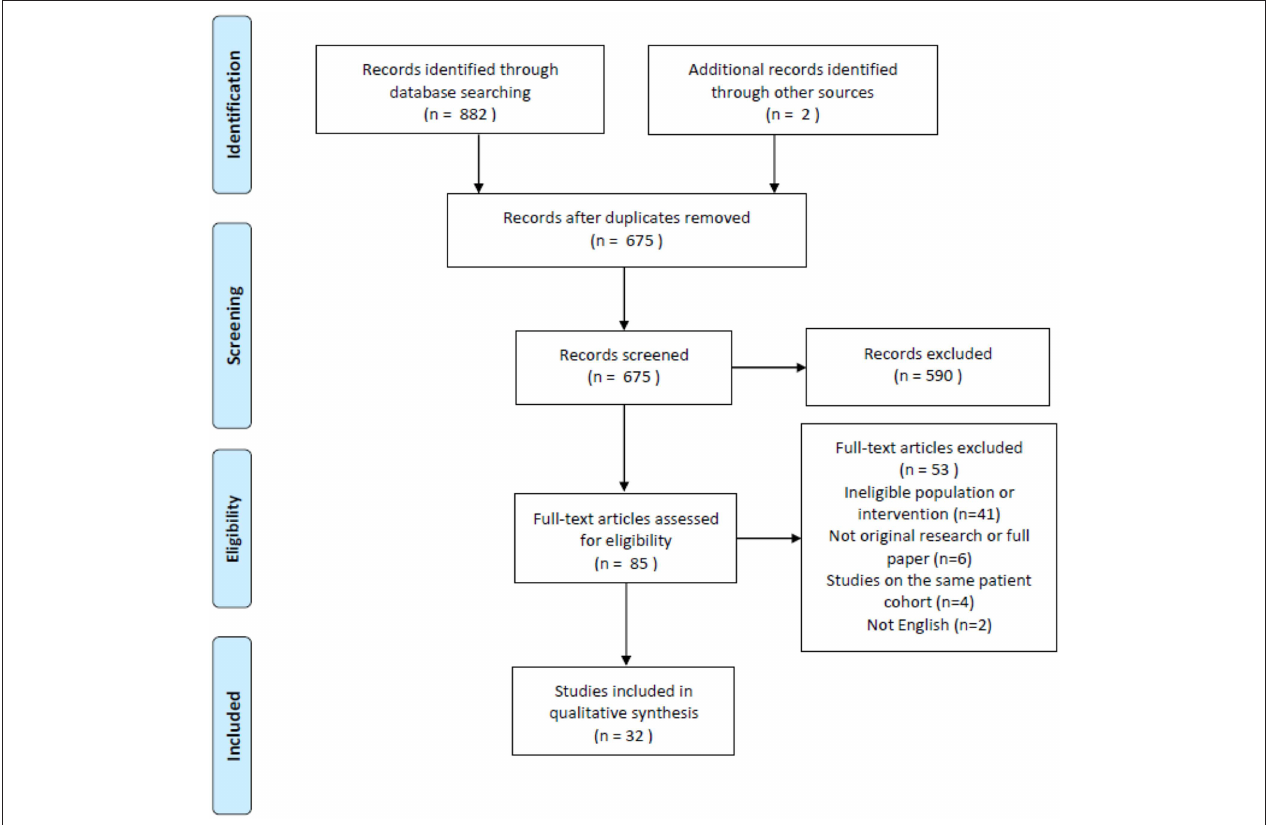
FIGURE 1 | PRISMA flow chart of search results